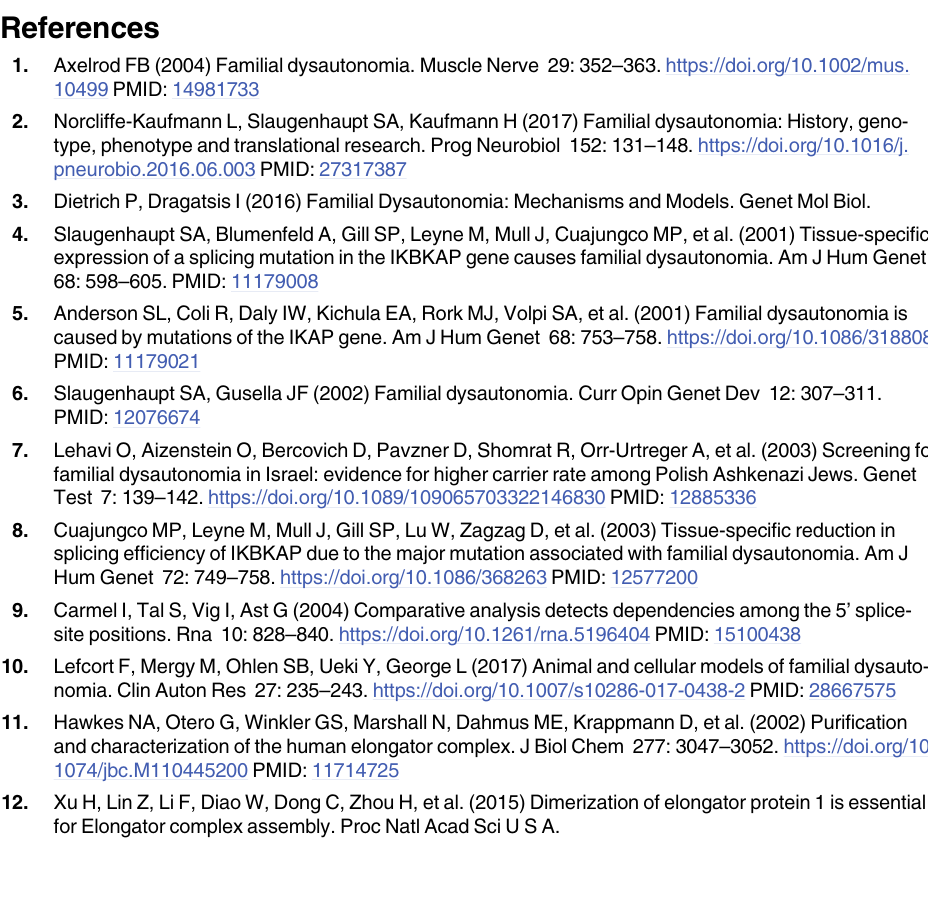
S1 Table. List of primers.